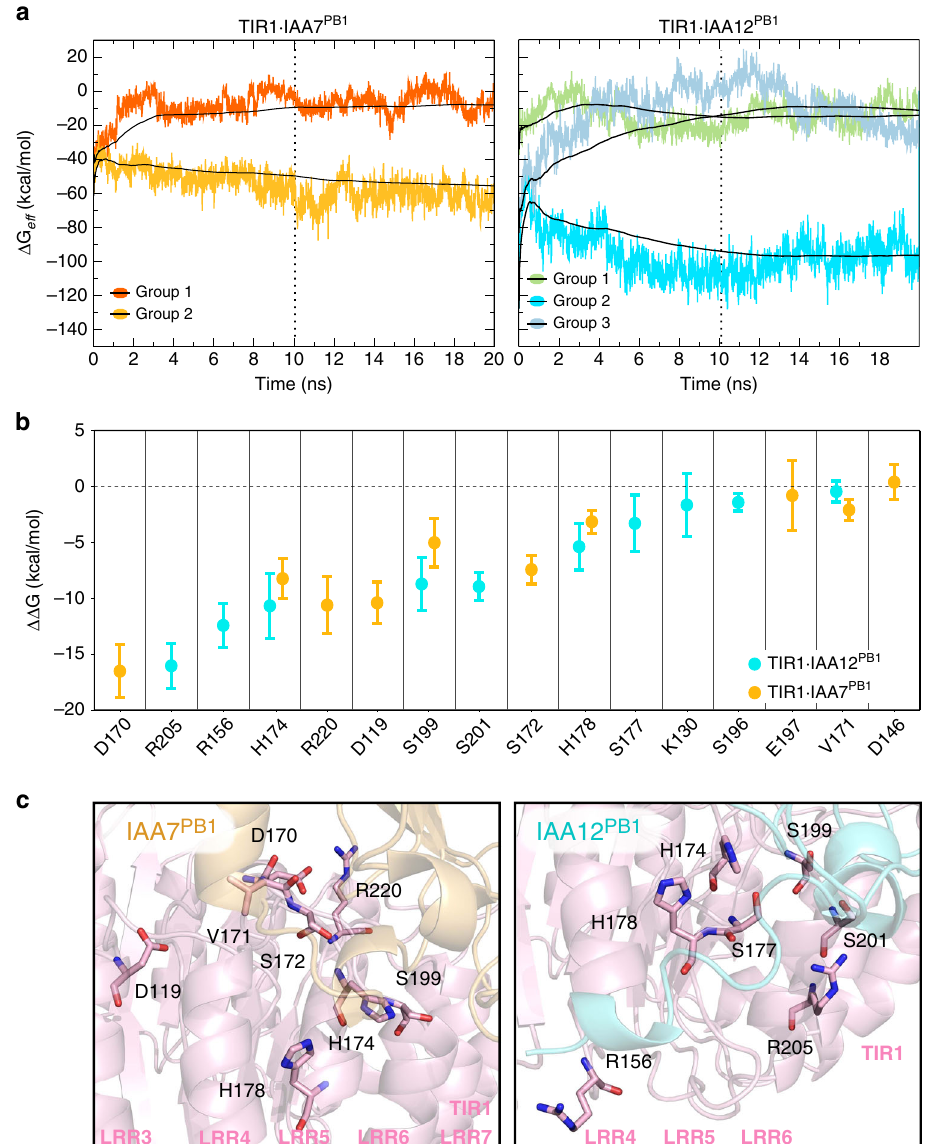
Fig. 6 Molecular dynamics simulations reveal energetically favorable TIR1·AUX/IAA PB1 -interacting moieties. a Time evolution of instantaneous Δ G eff values over 20 ns identifying stable TIR1·AUX/IAA PB1 complexes from HADDOCK best scoring groups (IAA7: cluster1_1; 2_1; and IAA12: cluster1_1; 2_1; 3_1). Black lines indicate the accumulated mean values of Δ G eff for each trajectory. One low energetic and stable complex (group 2, light orange